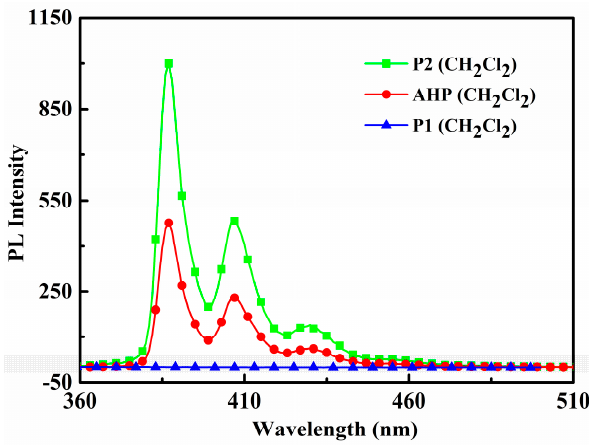
Figure 8. PL spectra of AHP, P1 , and P2 in CH 2 Cl 2 .